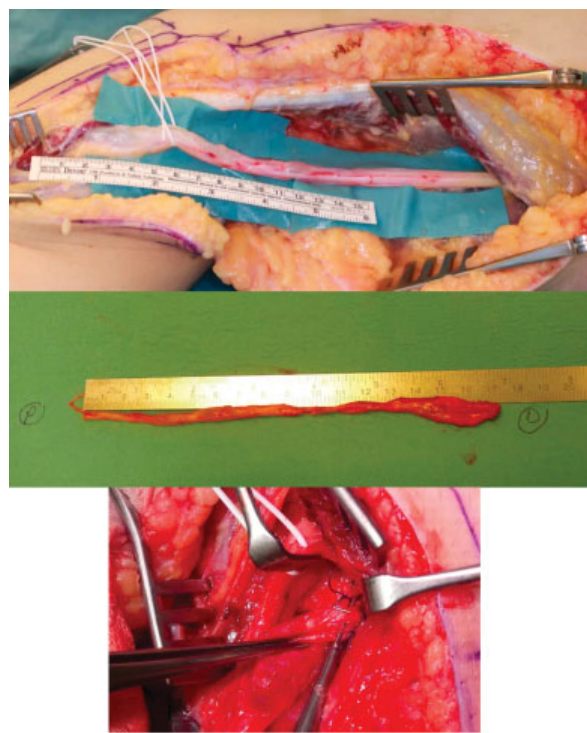
Fig. 2 Intraoperative view of the dissected left peroneal nerve (top), after microsurgical decompression and clipping (middle), and clipped articular branches of the cyst